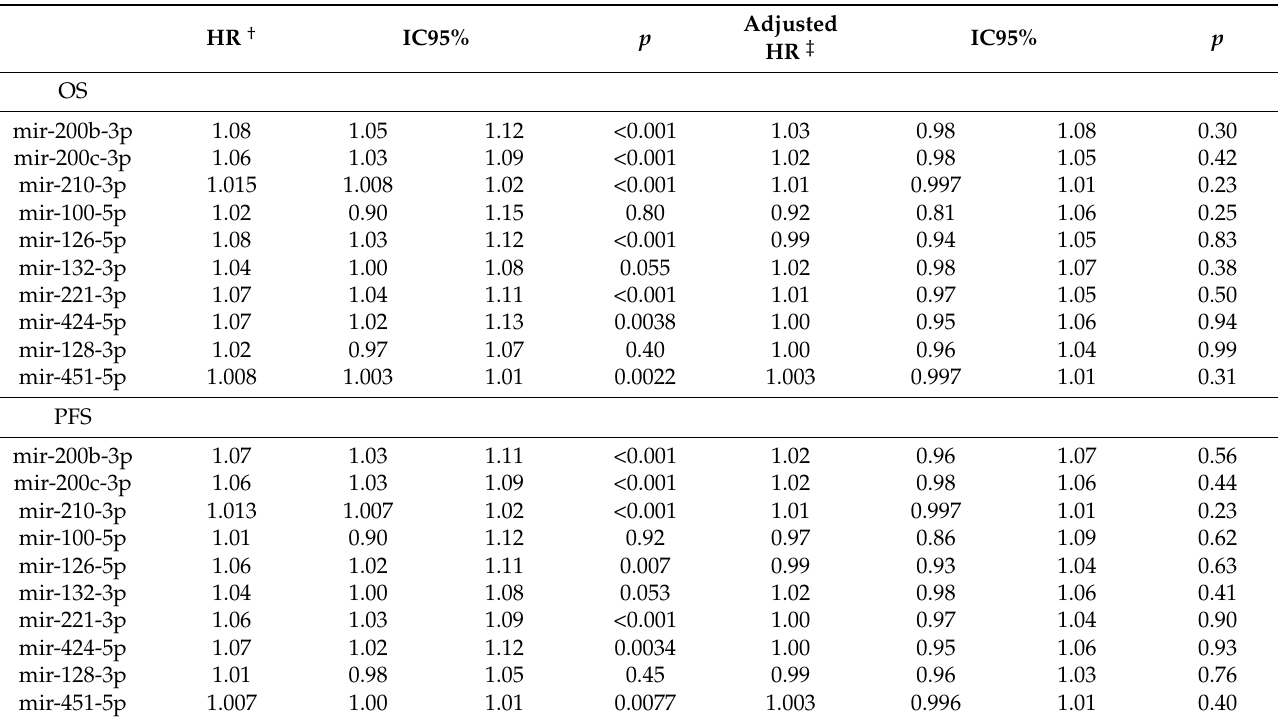
Table 5. MiRNA expression and overall and progression-free survival of patients with